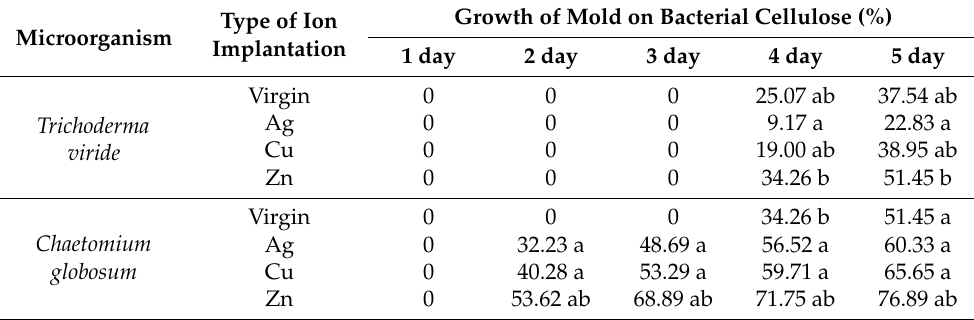
Table 4. Percentage growth of mold on the surface of bacterial cellulose depending on the implanta- tion with a beam of Cu, Zn and Ag ions.